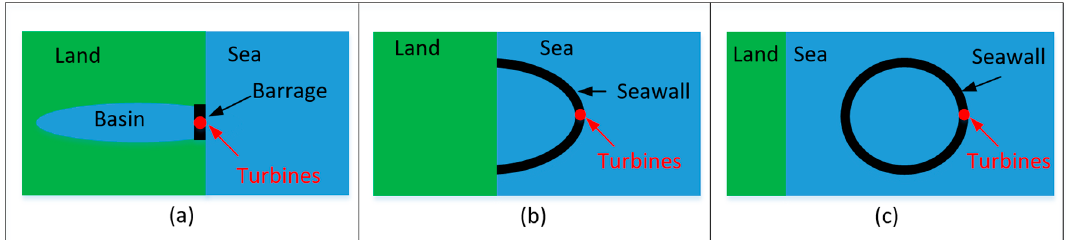
Figure 3. Different systems used for tidal generation; ( a ) tidal barrage; ( b ) tidal lagoon; ( c ) offshore lagoon.